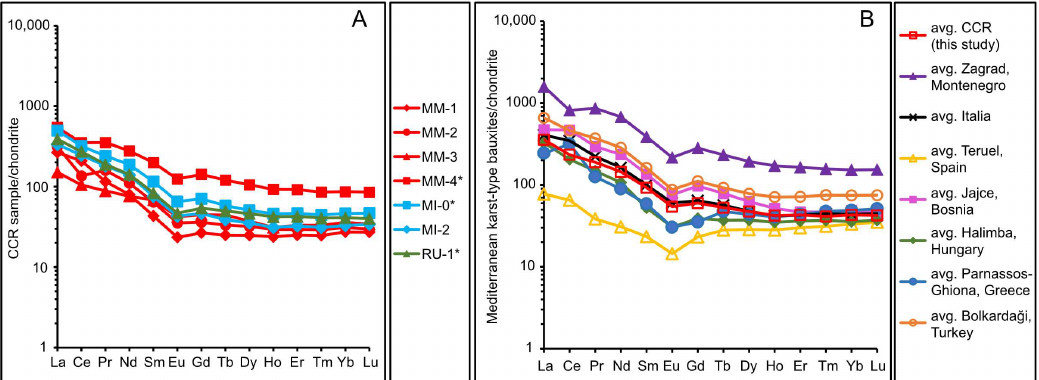
Figure 4. ( A ) Chondrite-normalized REE plot for whole rock data of the studied bauxitic samples of the CCR, MM-4*, MI-0*, RU-1* = average of two measurements. ( B ) Chondrite-normalized average